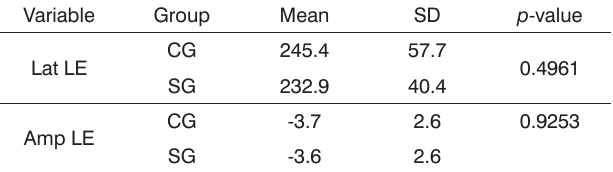
Table 8. Descriptive statistics of the mean, standard deviation (SD) and p -value of the MMNd latency and amplitude for the LE. Variable